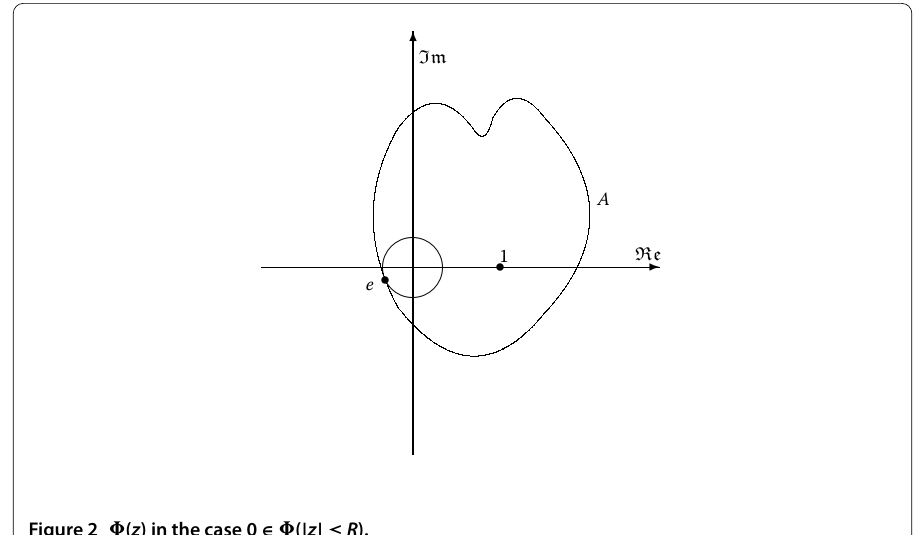
Figure 2 (cid:2) ( z ) in the case 0 ∈ (cid:2) ( | z | ≤ R